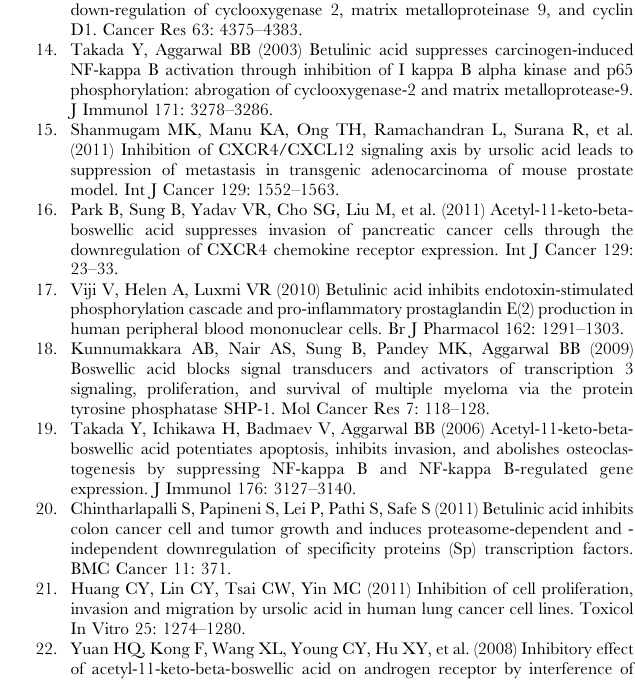
Figure S1 RB blocks NF- k B activation in a variety of